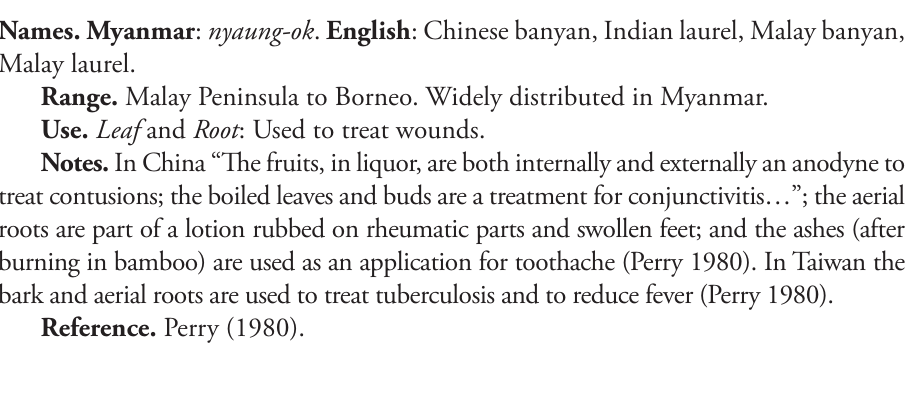
English : drooping fig. Range. Tropical Asia. In Myanmar found in Bago, Kachin, and Yangon. Use. Fruit : Used in aphtous